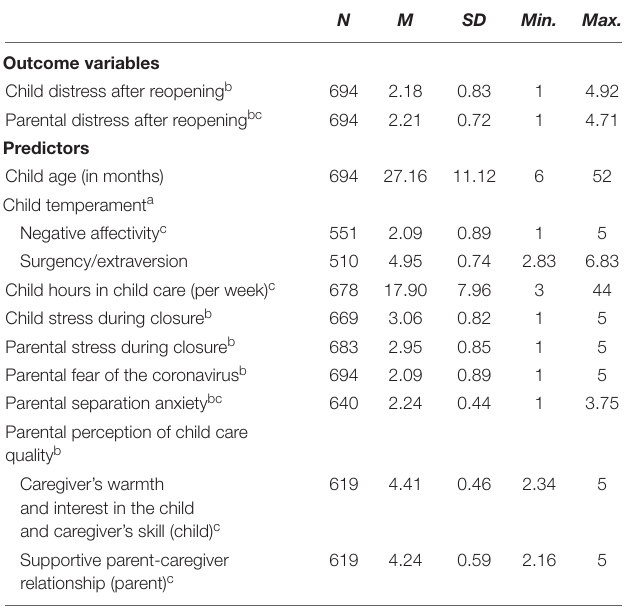
TABLE 1 | Descriptive statistics for the predictors and outcome variables. N M SD Min.